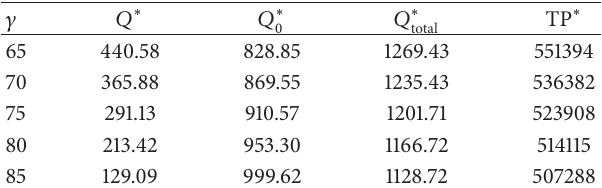
Table 2: Effect of changing 𝛾 on the optimal policy.